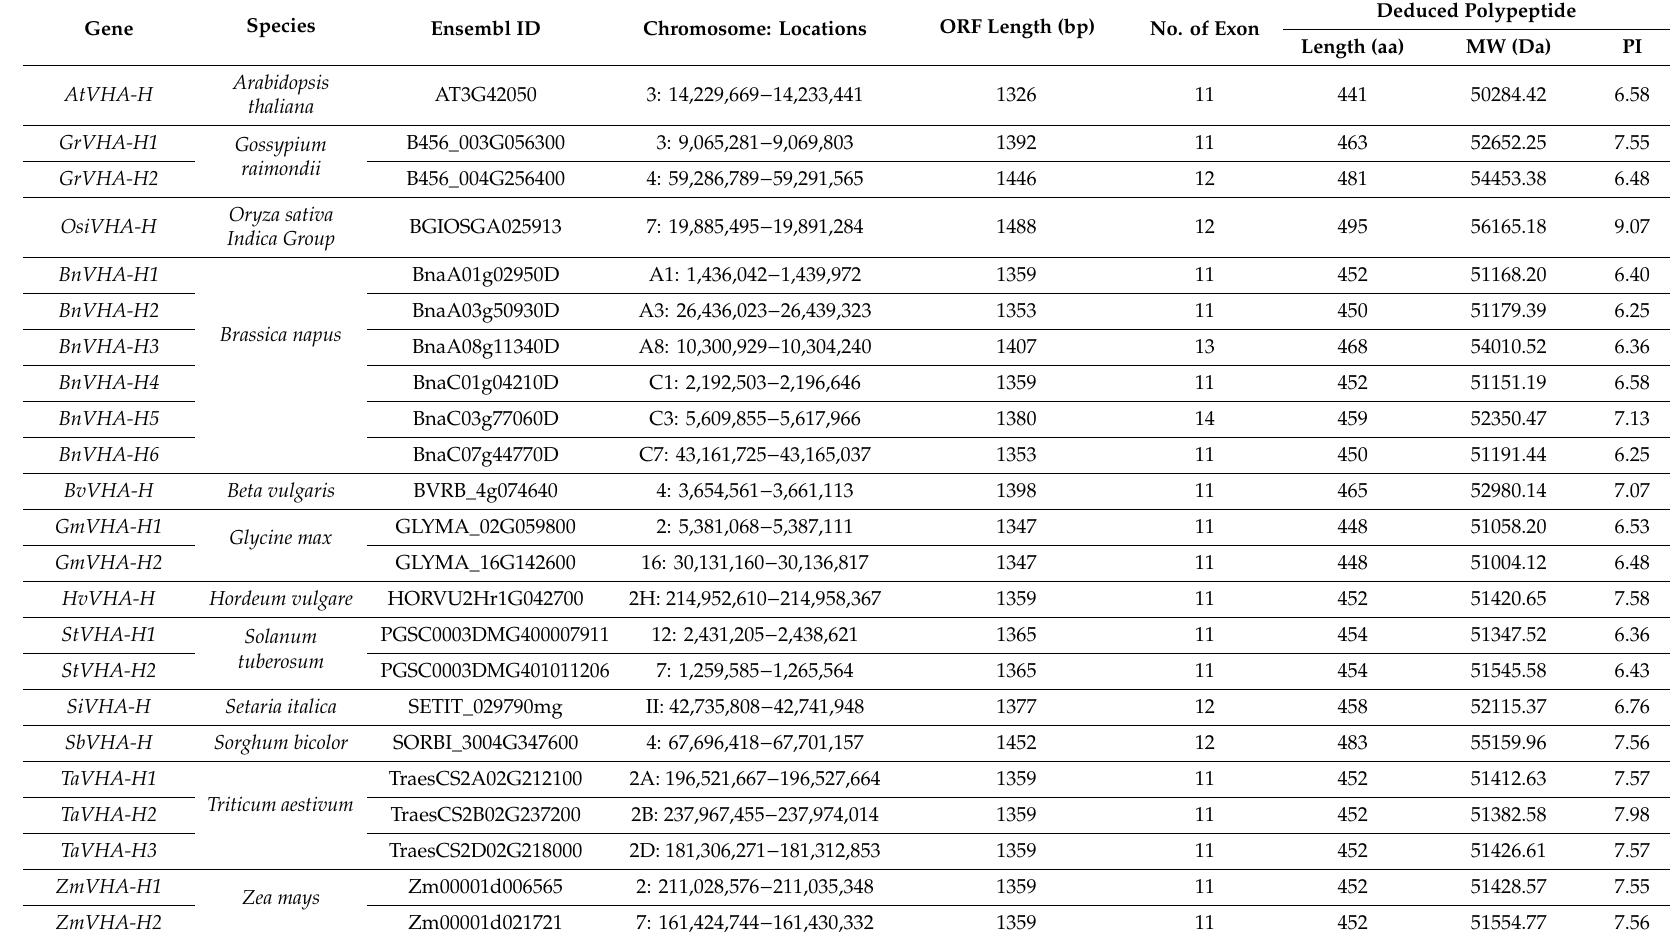
Table 1. Molecular characterization of 23 VHA-H genes in 12 species of